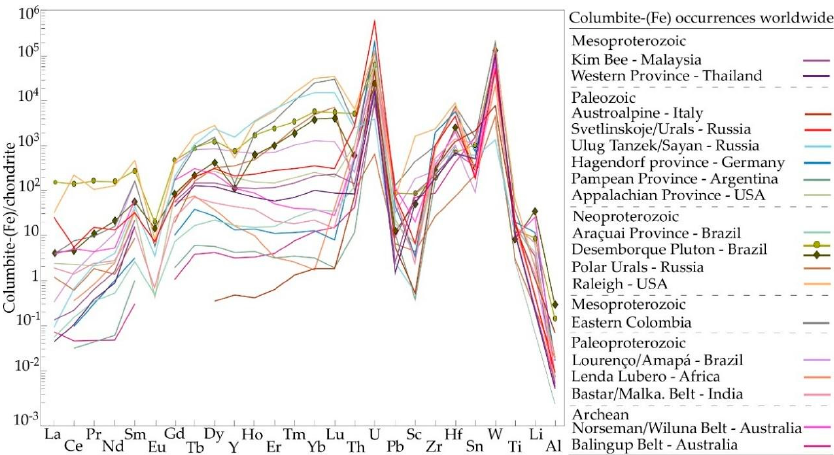
Figure 10. Average chondrite normalized rare-earth and trace element patterns for the studied columbite-(Fe) occurrences from the Desemborque Pluton, Brazil, and from pegmatites from worldwide provinces compiled by References [10,11].